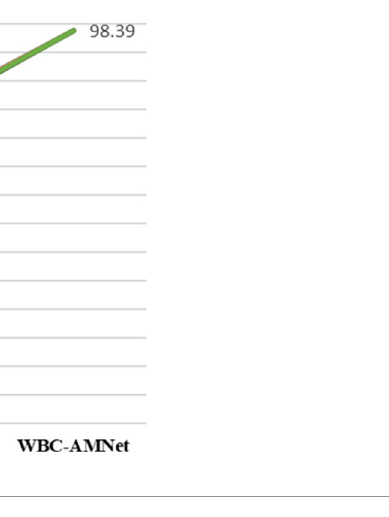
accuracy of monocytes is still not satisfactory. By integrating the GE module, the recognition accuracy of WBC-AMNet in monocyte is improved by nearly 10% compared with SE-Res- NeXt. Moreover, WBC-AMNet has an accuracy rate of over 95% for each WBC subtype. So far, we can come to the conclusion: WBC-AMNet has achieved effective WBC classification on WBCs dataset. Fig 10 shows that for quad-classification, our model, comparing to other 3 methods, still gets the higher scores of Accuracy, Specificity, Precision and F1-score.